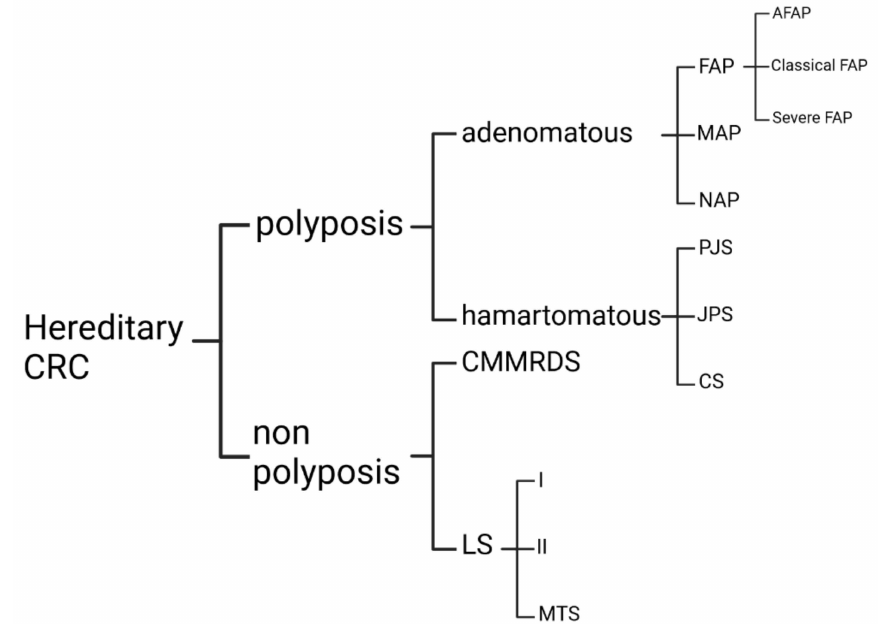
Figure 1. Classification of hereditary colorectal cancers (CRC) [13–15]. Abbreviations are as follows: FAP—familial adenomatous polyposis, LS—lynch Syndrome, MAP— MUTYH